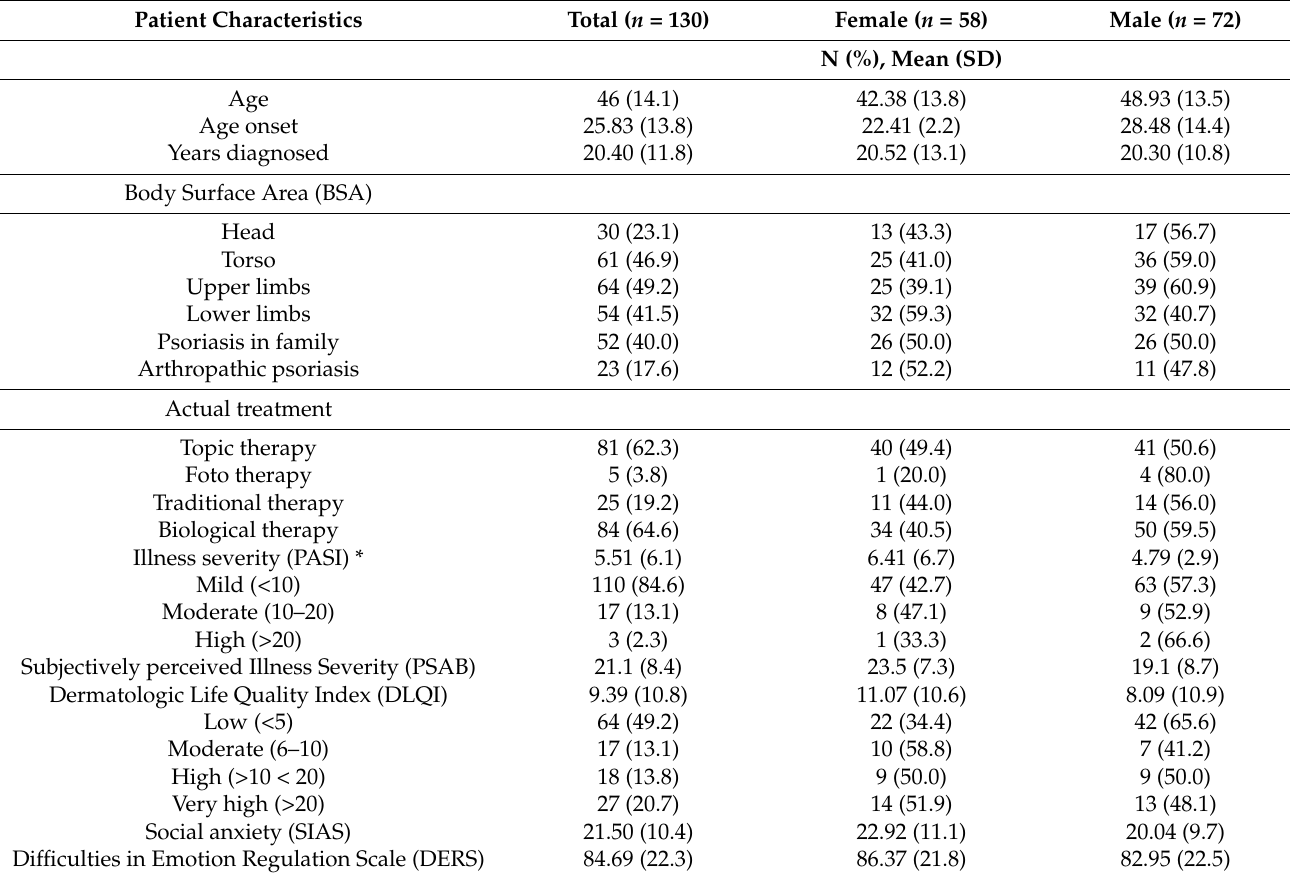
Table 1. Patient characteristics for the entire sample and for male and female patients separately. Patient